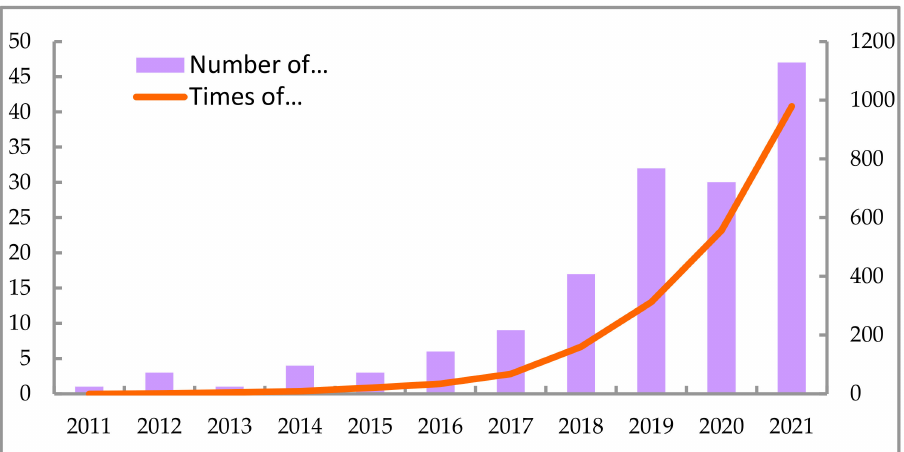
Figure 2. Numbers of publications and citations for urban park research using big data.